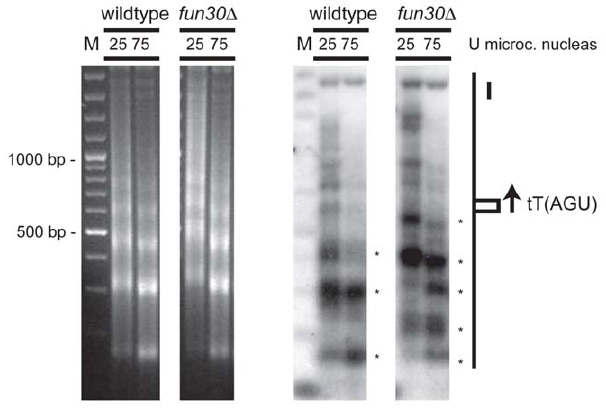
Figure 7. Fun30 regulates chromatin structure at the HMR boundary element Chromatin analysis using micrococcal nuclease digestion and indirect endlabeling. Spheroplasts were generated from both a wild-type yeast strain and the isogenic fun30 mutant strain and incubated briefly in the presence of increasing concentrations of micrococcal nuclease. The purified genomic DNA was then separated on an agarose gel and analyzed after ethidium bromide staining (left panels) or by Southern blot analysis for the HMR boundary region via indirect end-labelling (right panels). Asterisks indicate major digestion products. The position of the tRNA barrier is indicated by a small box. The arrow indicates the direction of transcription of the tRNA. The coding regions for a1 and GIT1 lie upstream and downstream, respectively, of the analysed fragment. The molecular size marker (M) is in multiples of 100 bp.